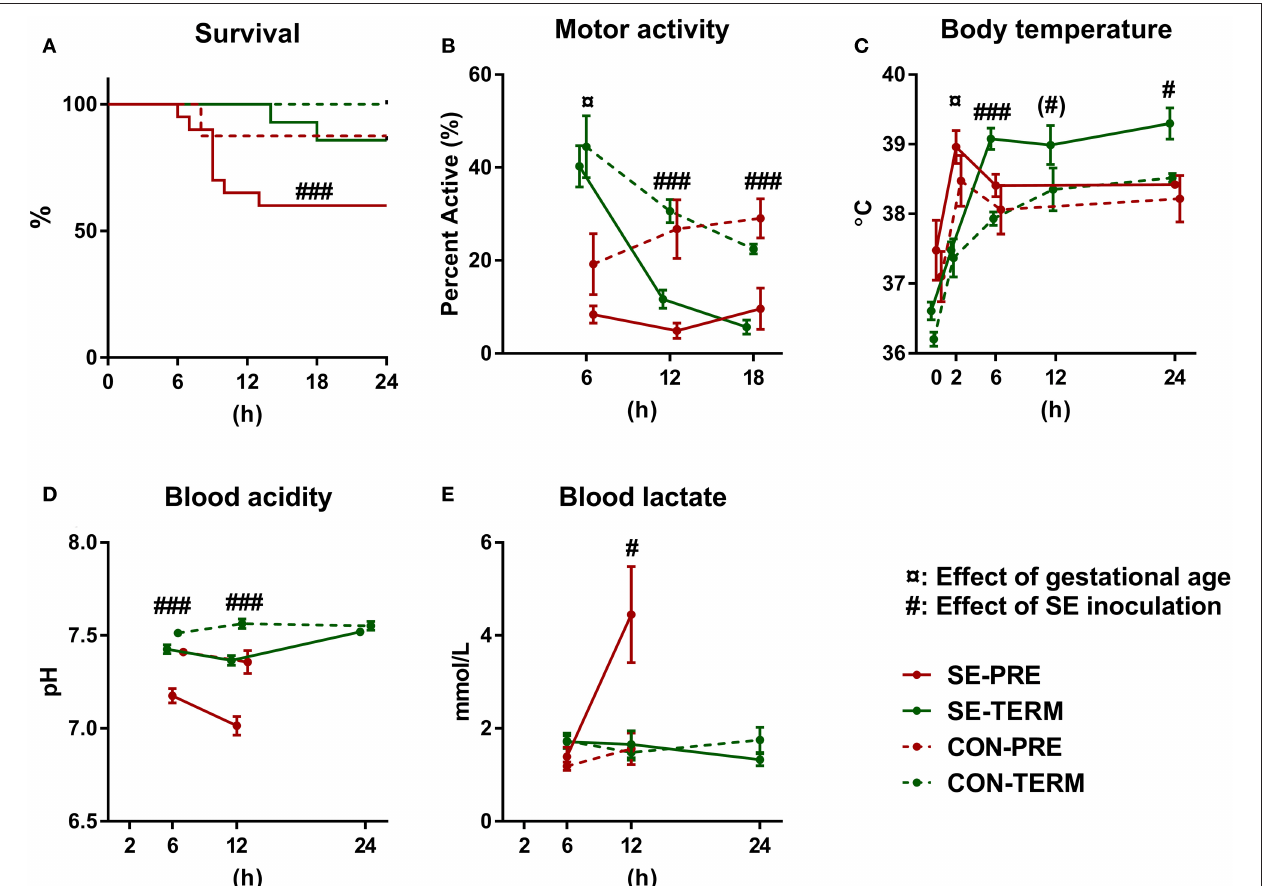
FIGURE 1 | Preterm birth increases susceptibility to Staphylococcus epidermidis bacteremia. Results of Experiment 1 comparing term (TERM) and preterm (PRE) pigs infused with Staphylococcus epidermidis (SE) or saline (CON) immediately after birth, without any enteral feeding. (A) Survival rates 24h post inoculation. (B) Motor activity, shown as the fraction of time when pigs were physically moving at 2–18h post inoculation. (C) Body temperature 2–24h post inoculation. (D) Blood pH 6–24h post inoculation. (E) Blood lactate levels 6–24h post inoculation. (A) Presented as Kaplan Meyer curves. (B–E) Presented as means with